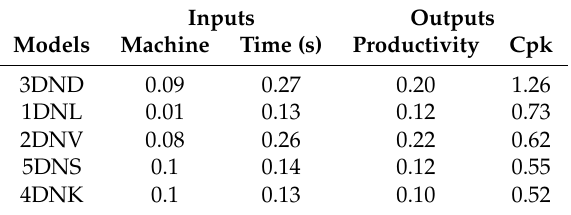
Table 14. DEA model